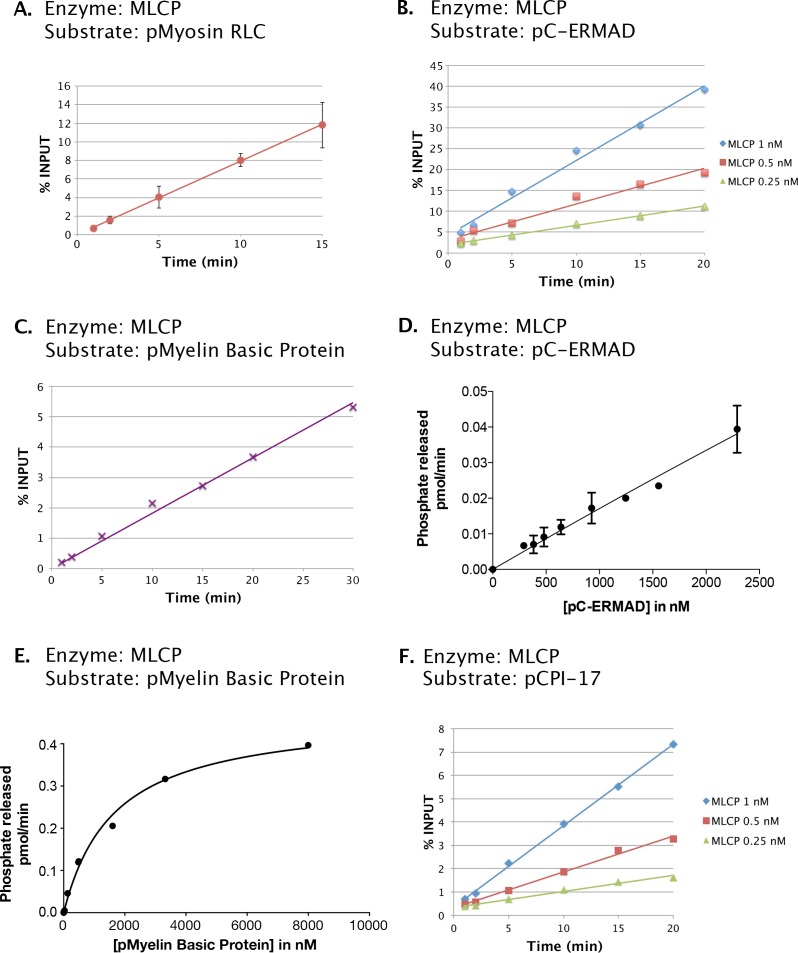
Phosphatase activities of the MLCP preparation shown in Figure 2.Enzyme assays as described in Materials and methods were performed at 30°C with the following components in 6 μL reactions unless otherwise noted: (A) 0.5 μM myosin regulatory light chain phosphorylated by myosin kinase (pMyosin RLC) and 0.5 nM MLCP. (B) 1 μM C-ERMAD phosphorylated by LOK (pC-ERMAD) and MLCP at the concentrations shown. (C) 0.7 μM Myelin Basic Protein phosphorylated with PKA (pMyelin Basic Protein) and 0.5 nM MLCP. (D) pC-ERMAD at the amounts indicated and 0.25 nM MLCP. (E) pMyelin Basic Protein at the amounts indicated and 1.67 nM MLCP, in a volume of 30 μL. (F) 1.6 μM CPI-17 phosphorylated with PKCδ (pCPI-17) and MLCP at the concentrations shown. In (A), (C), and (D), data points represent the average and standard deviation of three trials; in (B), (E), and (F) each point corresponds to a single trial. The results of (A), (B), (C), and (F) show that all assays described in the remainder of this report were conducted in the linear range. The near linearity of the velocity versus substrate concentration curve in (D) indicates that the Km for the dephosphorylation of pC-ERMAD by MLCP must be considerably in excess of 2.5 μM, the highest concentration of pC-ERMAD achieved.